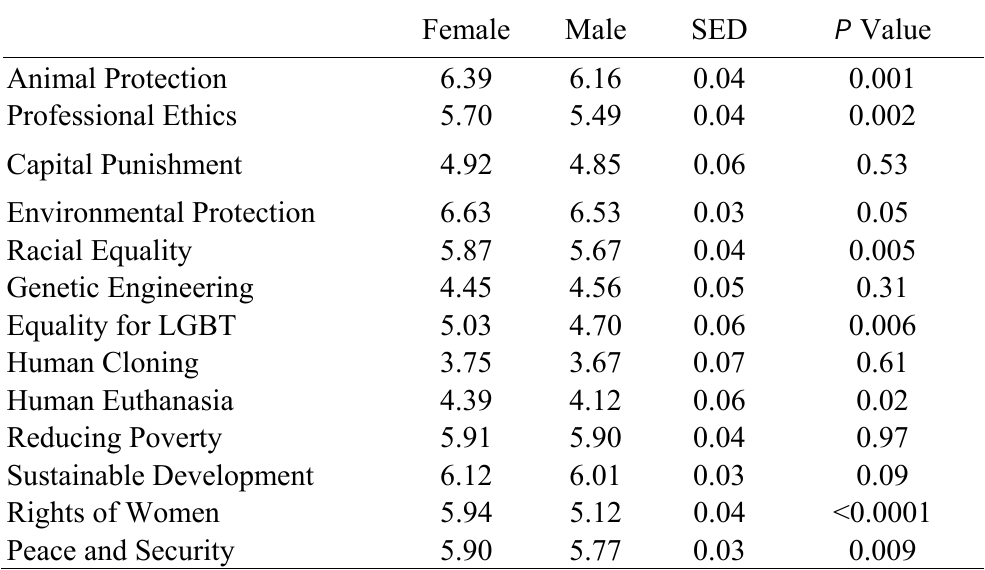
Table 9. The effects of gender on mean scores for World